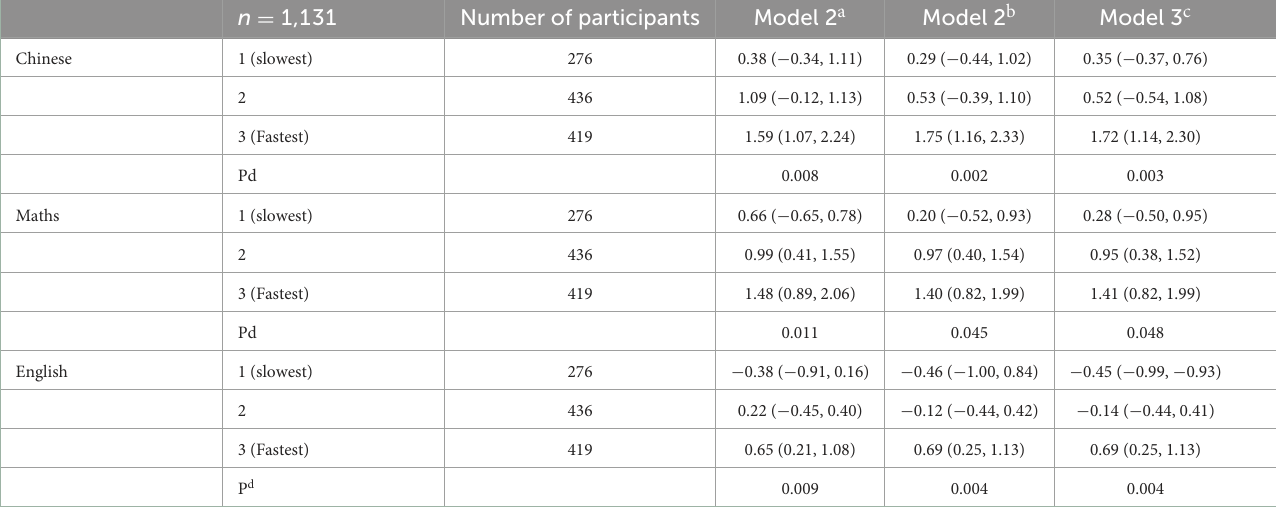
TABLE 7 Multivariable-adjusted relationships of 1-min sit-ups with change in academic performance during the 3-year follow-up period. n =